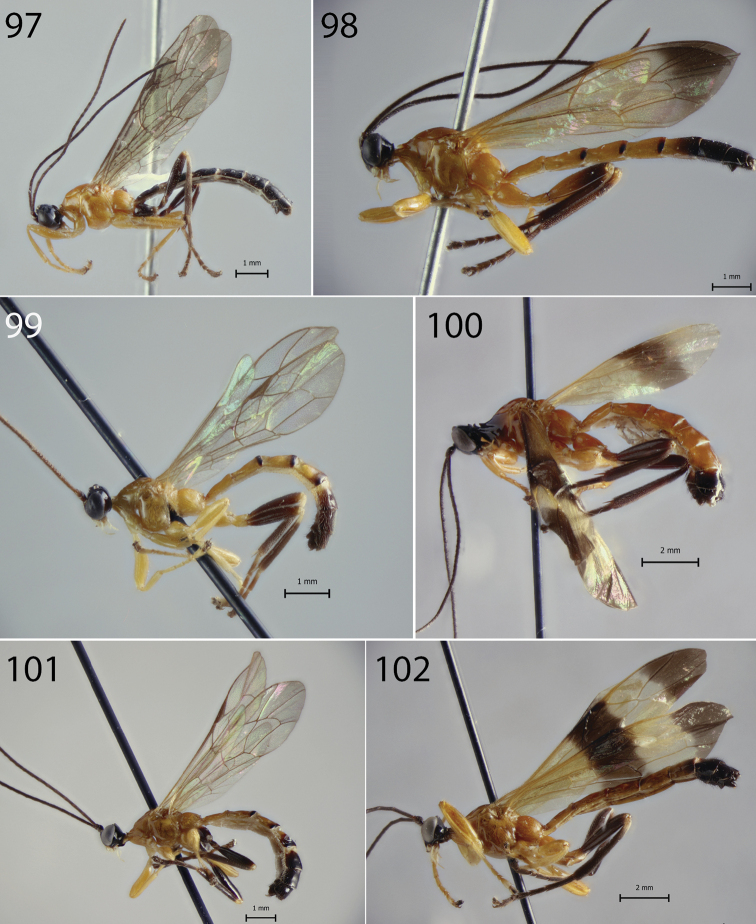
Habitus of Hymenoepimecis spp. (males), lateral view 97H.
andina sp. nov. (paratype) 98H.
bicolor99H.
dolichocarinata sp. nov. (paratype) 100H.
duckensis101H.
kleini102H.
longilobus sp. nov. (paratype).